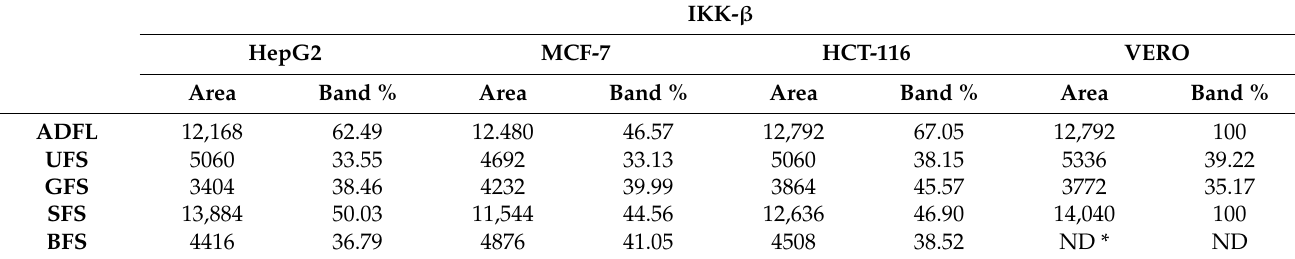
Table 7. Protein expression levels of IKK- β in HepG2, MCF-7, HCT-116, and VERO cell lines exposed to IC 50 of air-dried fenugreek leaves (ADFL), unprocessed fenugreek seeds (UFS), germinated fenugreek seeds (GFS), soaked fenugreek seeds (SFS), and boiled fenugreek seeds